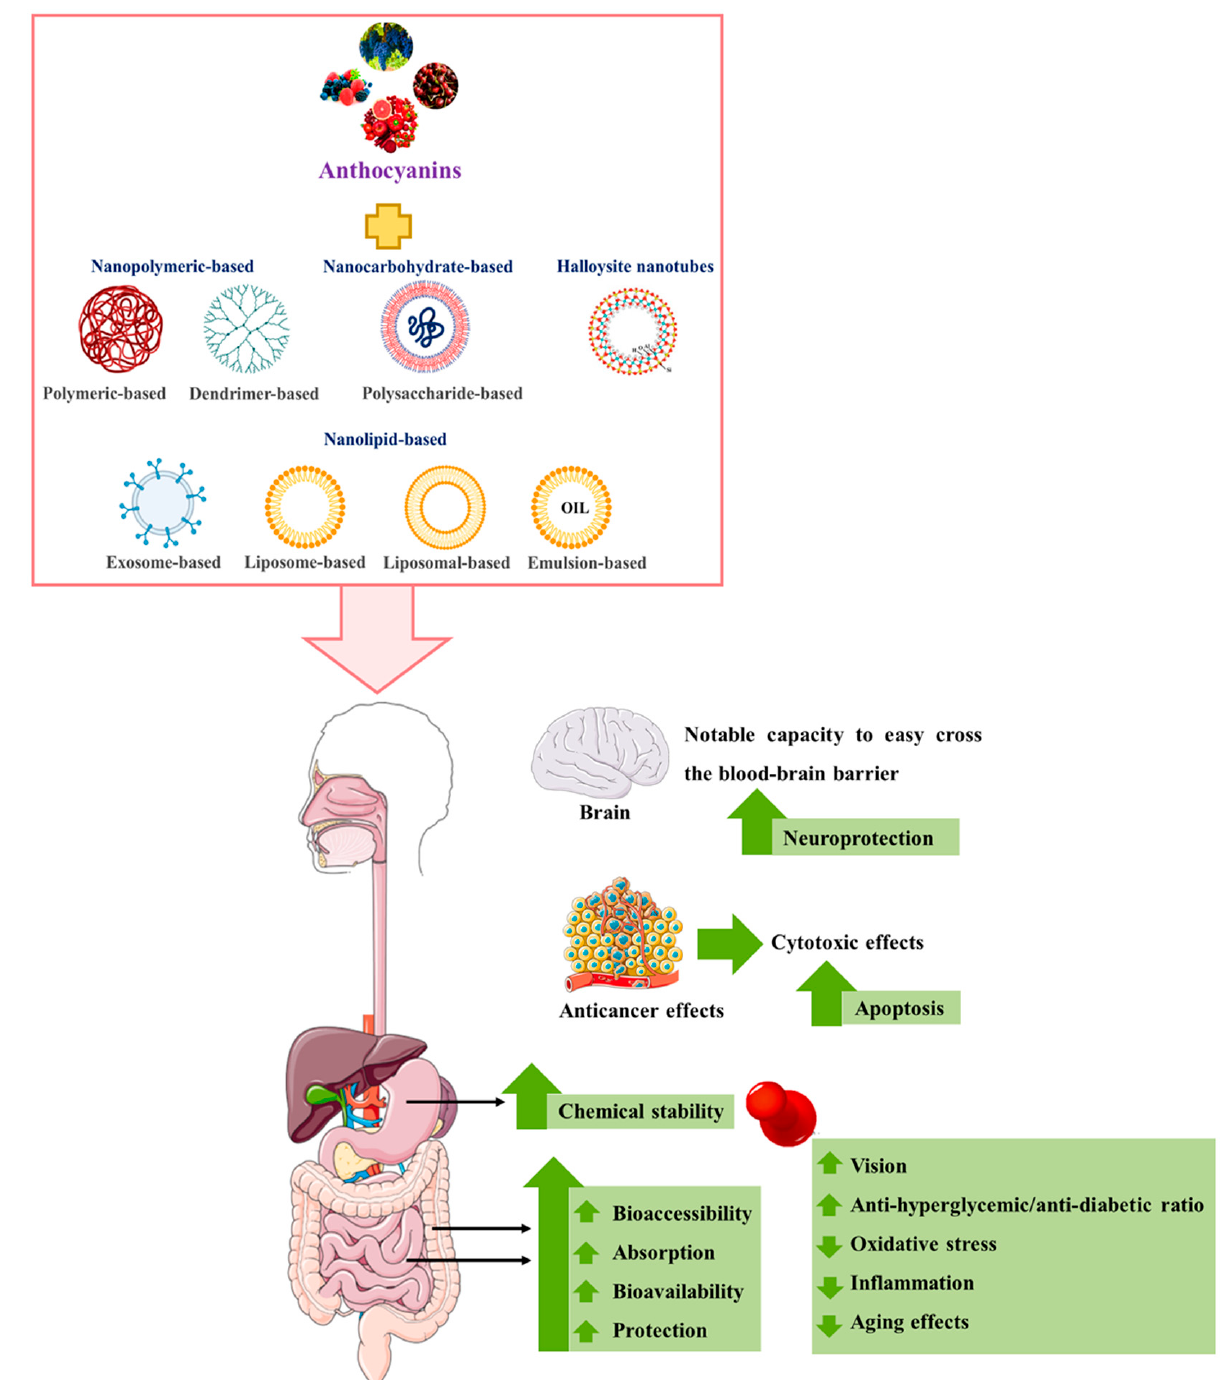
Figure 4. Main in vitro and in vivo effects of anthocyanins-loaded nanocarriers. ↑ : increase; ↓ : decrease. (Portions of Figure 4 were drawn using images from Servier Medical Art. Servier Medical Art by Servier is licensed under a Creative Commons Attribution 3.0 Unported License (https://creativecommons.org/licenses/by/3.0/) and BioRender.com (https://biorender.com/) (both accessed on 6 August 2022) and from Guimarães [195]).